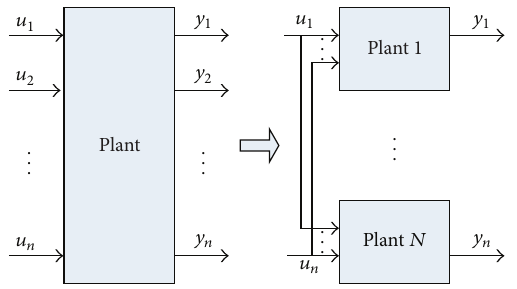
Figure 1: The architecture of the MIMO nonlinear system.